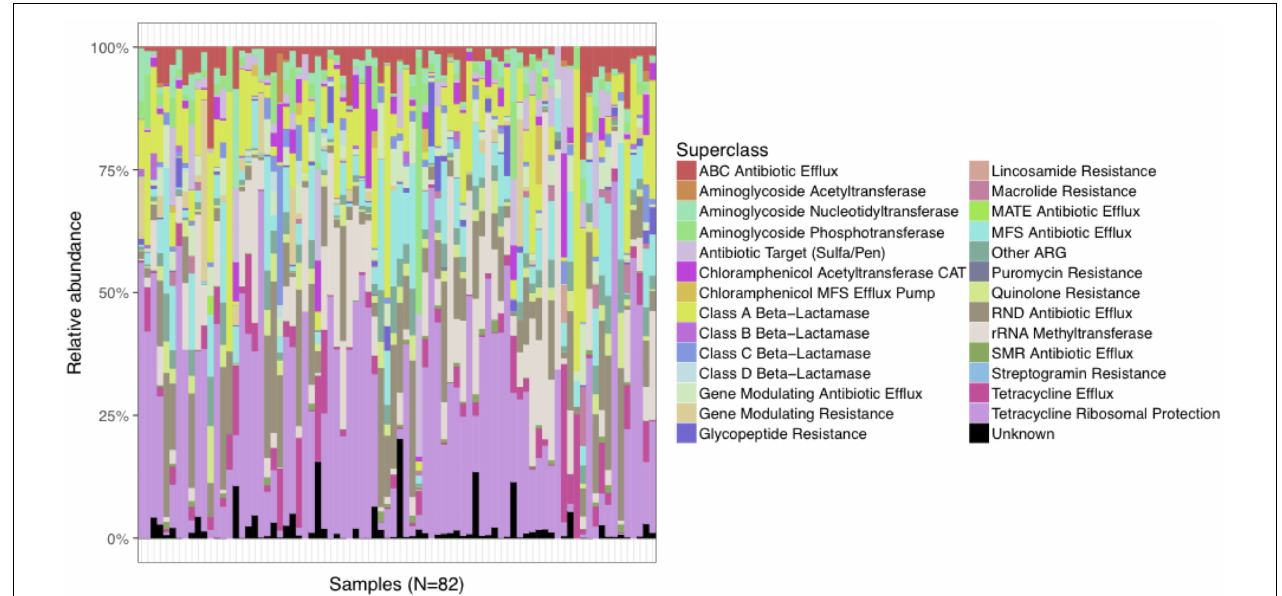
FIGURE 1 | Distribution of relative abundances of the most abundant AR gene superclasses among the 82 subjects in the study cohort. Every subject had one or more tetracycline-resistance gene, and > 90% had at least one AR gene classified as Class A Beta-Lactamase, RND Antibiotic Efflux, MFS Antibiotic Efflux,